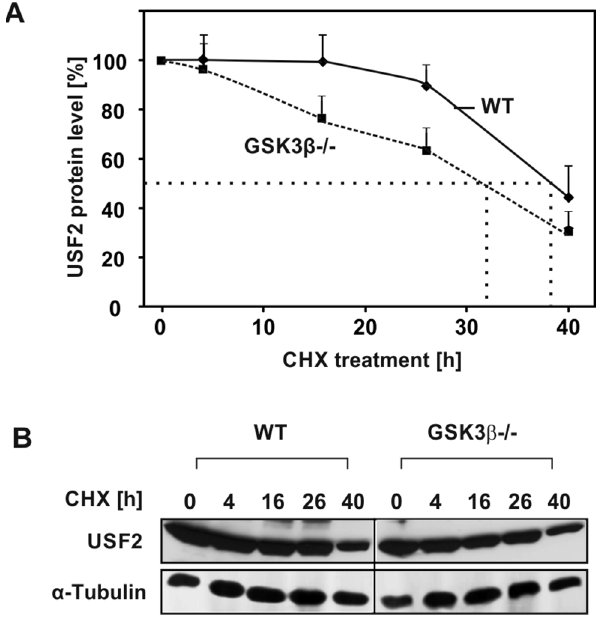
Figure 6. The half-life of USF2 is induced upon GSK3 b - dependent phosphorylation. (A) GSK3 b + / + and GSK3 b 2 / 2 cells were treated with 10 m g/ml CHX for the indicated time periods. Proteins were isolated, separated by SDS-PAGE and detected by Western blotting. Protein levels were quantified and the relative protein level of USF2 was blotted against the duration of CHX treatment for estimation of the half-life. The dashed line indicates the USF2 half-life where 50% of the USF2 protein level was reached. (B) Representative Western Blot. 50 m g of protein from were probed with an antibody against USF2 and a -tubulin.